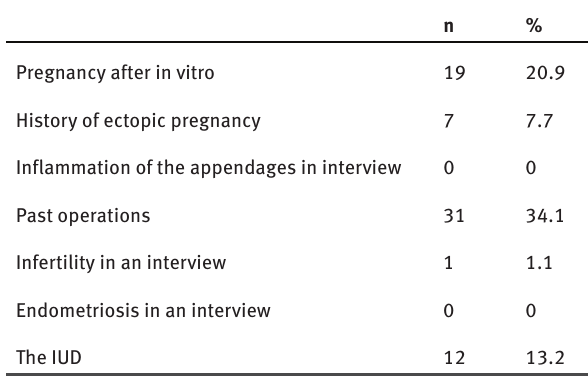
Table 2: Risk factors for ectopic pregnancy.